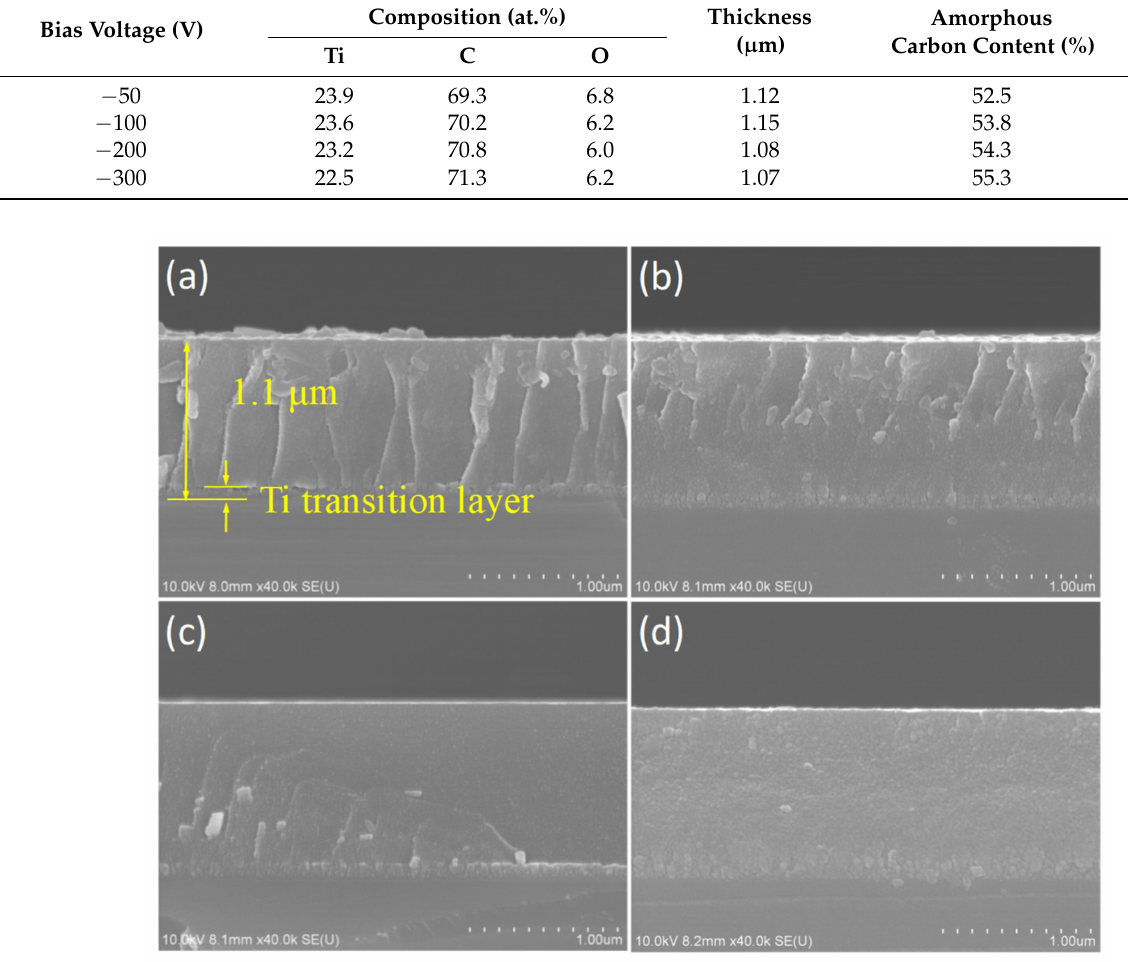
Figure 1. SEM images of cross-sections of Ti-DLC coatings prepared at varied substrate